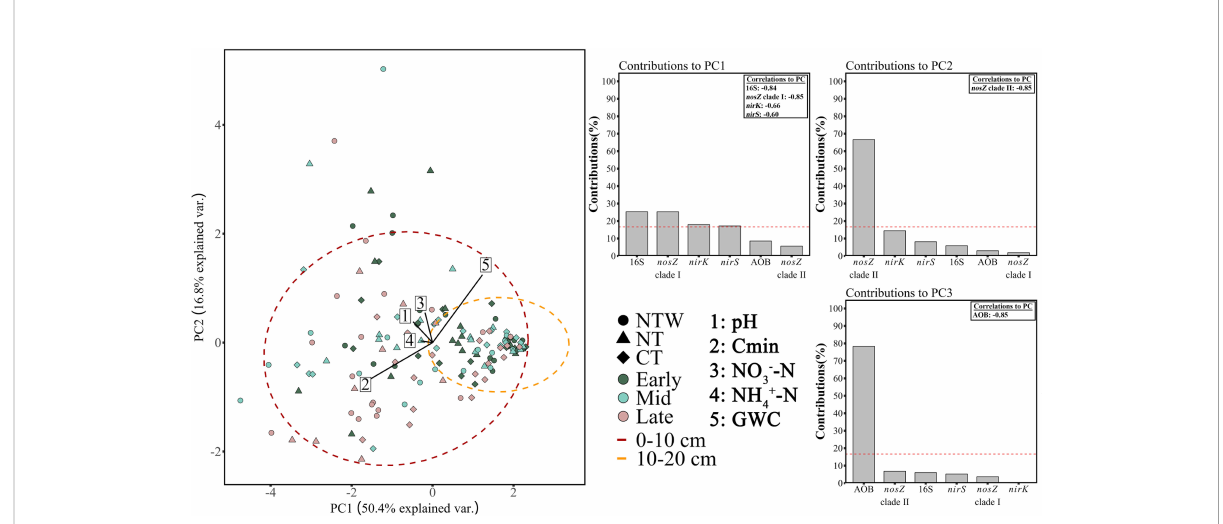
FIGURE 2 Principal components analysis of bacterial nitrogen cycle gene abundances. Gene abundance contributions to each PC are presented with correlations between signi fi cant contributors and each PC. Environmental variables were fi t to the ordination and their associated vectors are displayed at 4× size for ease of visualization. Ellipses denote clusters of samples by depth. Control, no-added nitrogen (N) fertilizer; PP, pre- plant fertilizer application at a rate of 168 kg N ha -1 ; SPLIT, 40% preplant, 60% mid-season application of N fertilizer at a total rate of 168 kg N ha -1 . Early, early-season sampling (June); Mid, mid-season sampling (August); Late, late-season sampling (October). GWC, gravimetric water content; Cmin, mineralizable carbon content; NO − 3 -N, nitrate; NH + 4 -N